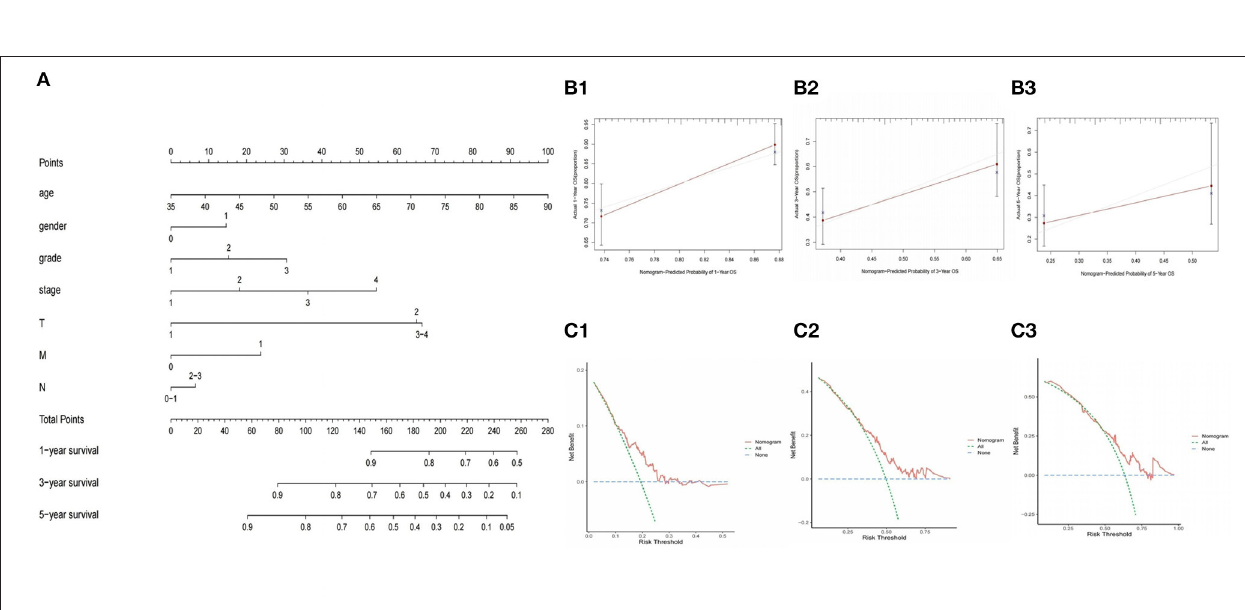
Frontiers in Surgery |